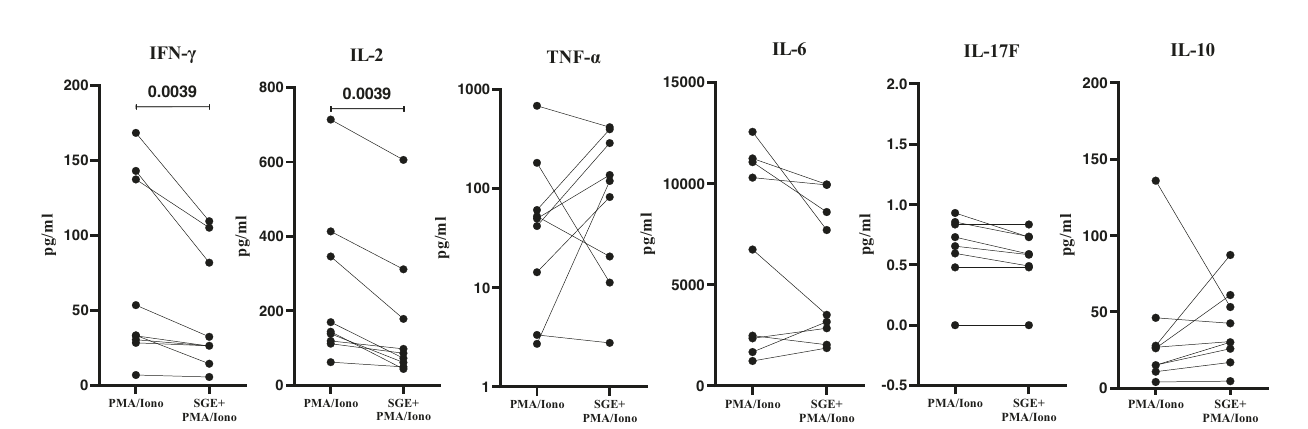
Fig.7|Humanskincellsobtainedfrom Ae.aegypti bittenskinstimulatedby Ae. aegypti salivary gland extract (SGE) produce signi fi cantly less pro- in fl ammatory cytokines (IL-2 and IFN- γ ). Cytokine production measured in skin cell culture supernatant after treatment with PMA/Ionomycin in the presence or absenceofSGE.Skindissociatedcellswereseededonround-bottom96-wellplates